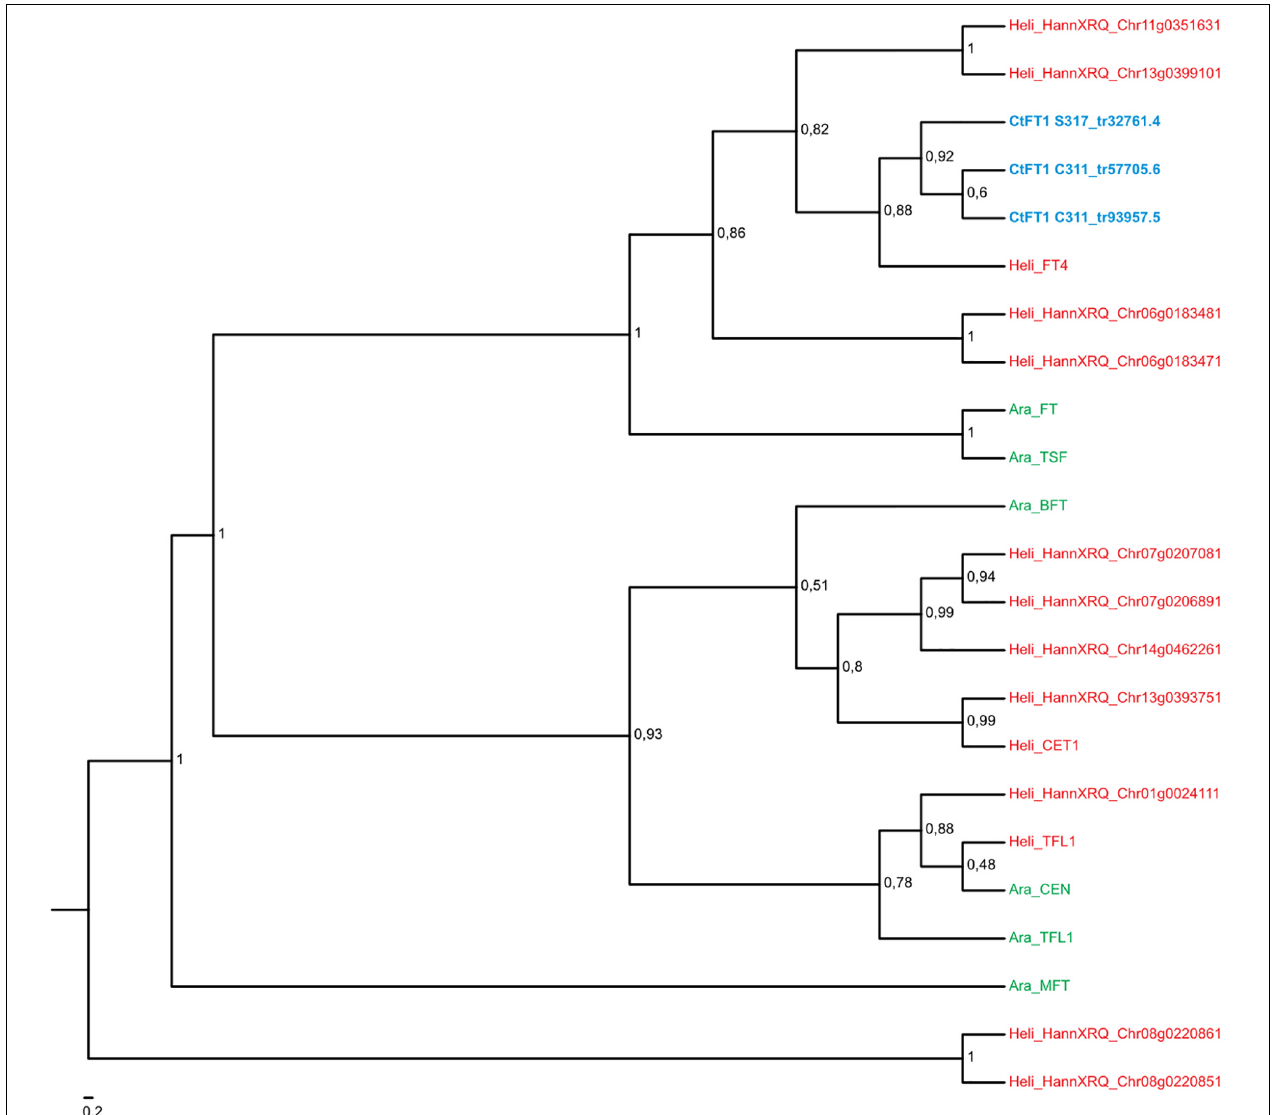
FIGURE 4 | Maximum likelihood phylogeny of the MIKC-MADS gene family in Arabidopsis thaliana (in green) and Helianthus annum (in red). Transcripts of Carthamus tinctorius (in blue) found to be differentially expressed in response to vernalization were included. Bootstrap support values are shown for nodes with higher than 50% support. CtMAF1 sequences from spring safflower (S317_tr33367.4 and S317_tr33367.5) appear to be isoforms of the same transcript, with variations found in the 3 (cid:48) end of S317_tr33367.4. Similarly, the CtMAF1 sequences from the winter safflower transcriptome (C311_tr20021.6 and